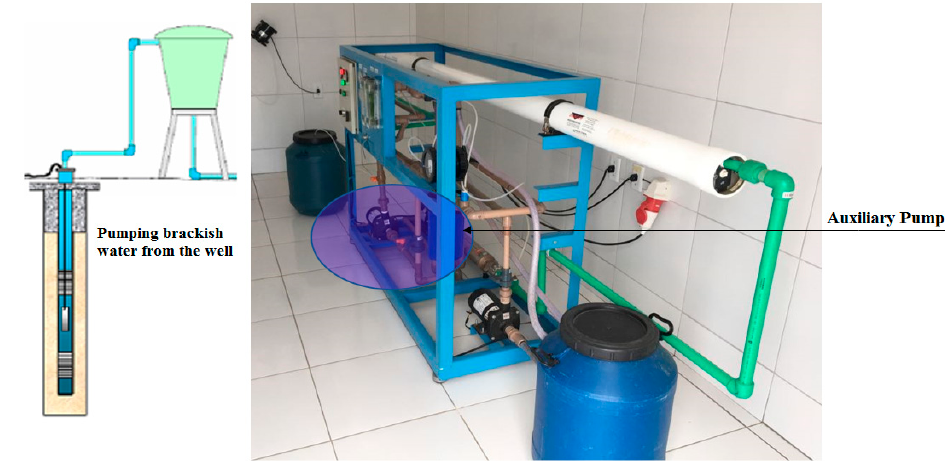
Figure 2. Desalination system used by the PAD.